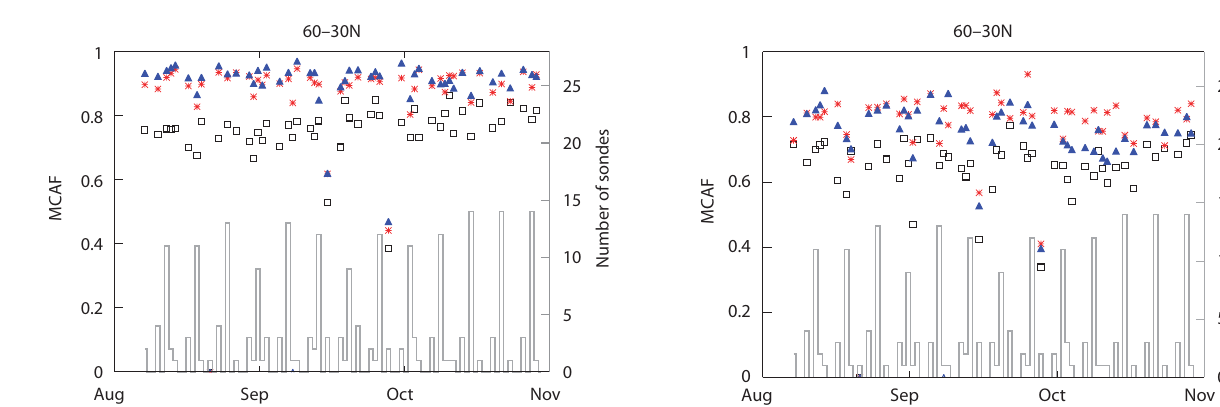
Figure 11. As Fig. 10 but for the tropospheric contribution assumed as the contribution from the layer spanning the atmosphere from the surface up to